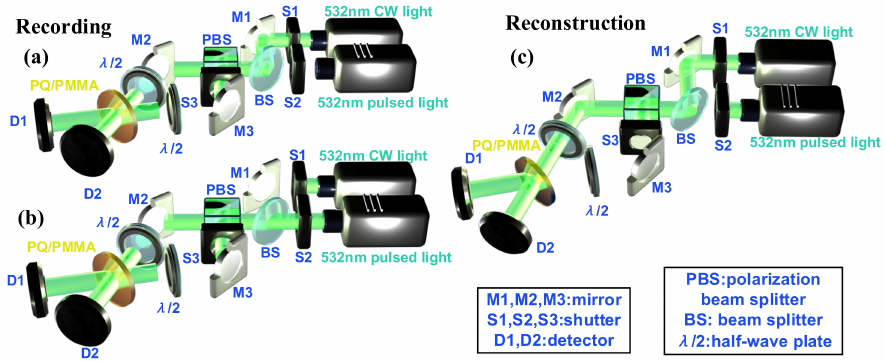
Figure 1. Holographic storage system. ( a ) The recording process under ms level, ( b ) the recording process under ns level, ( c ) the reconstruction process by CW